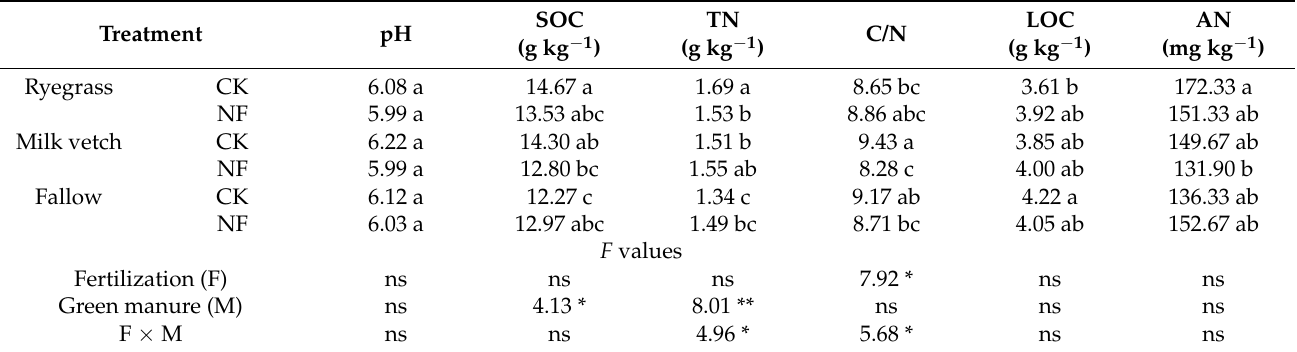
Table 2. Soil properties after rice harvest in